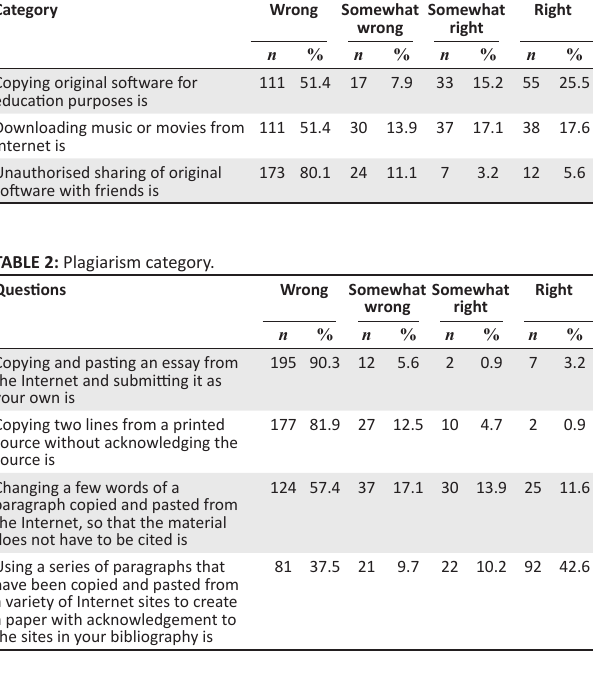
TABLE 1: Software piracy category. Category Wrong Somewhat